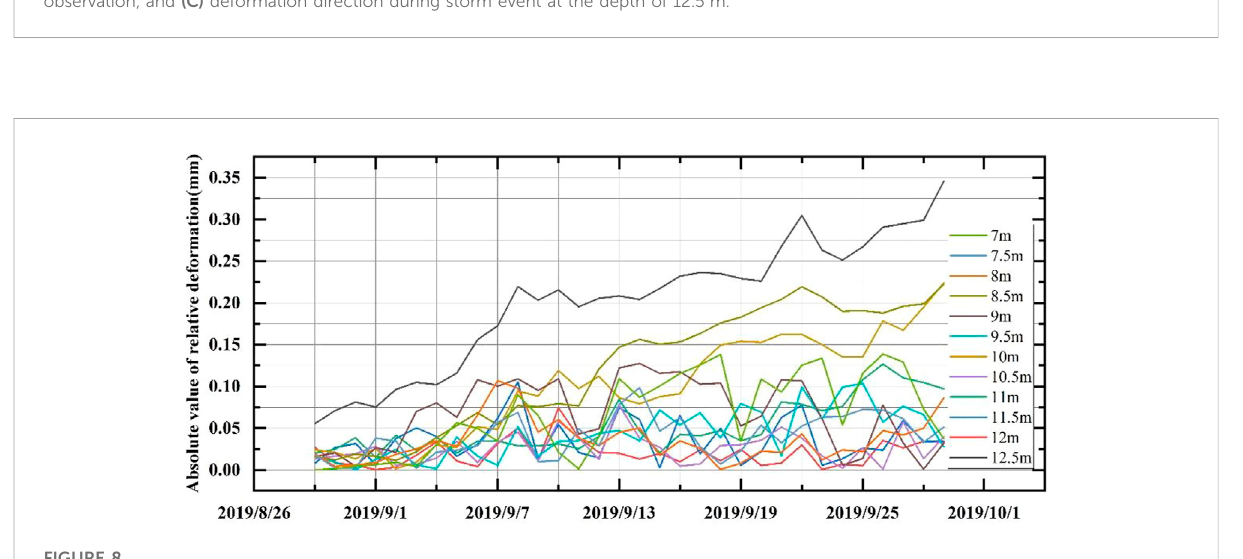
FIGURE 8 Absolute value of relative deformation during